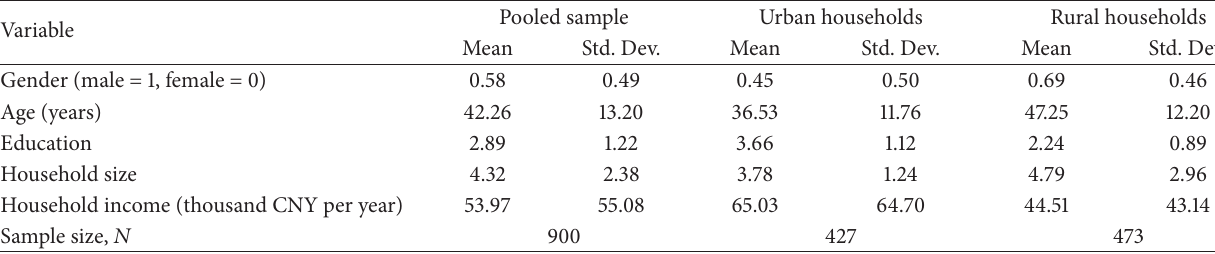
Table 4: Sociodemographics of the respondents.